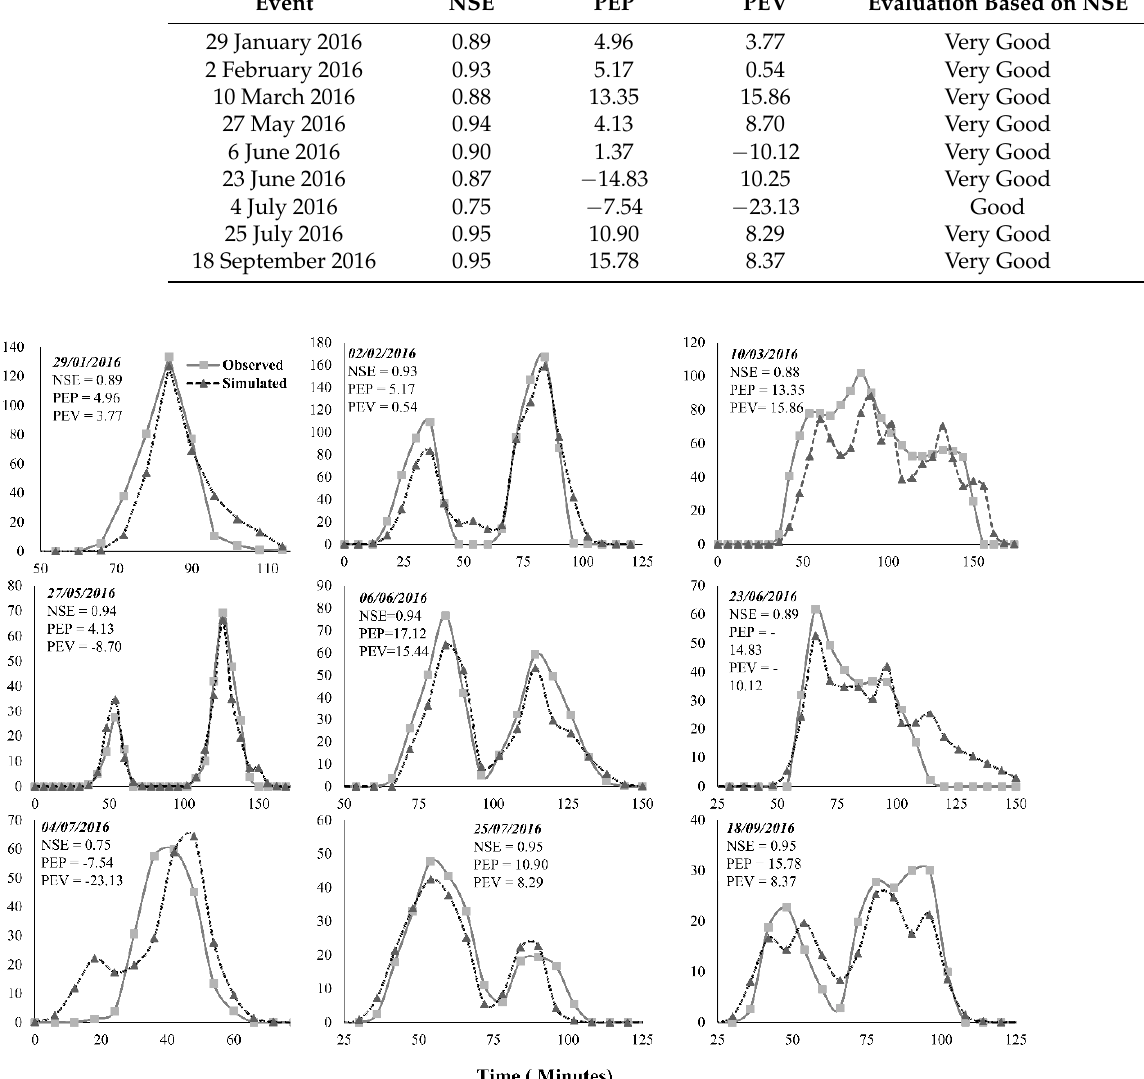
Table 4. Goodness-of-fit statistics for individual storms as extracted from the continuous runoff series. The model performance during each storm was also evaluated based on NSE values.